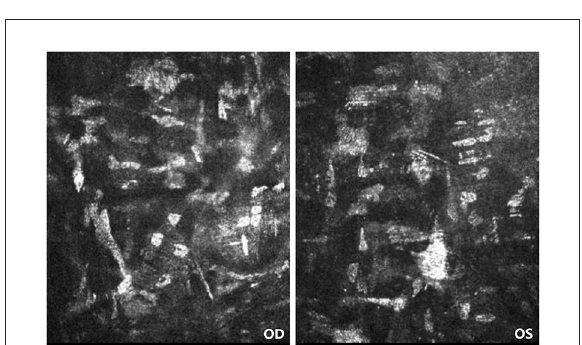
FIGURE2 Confocal microscopy of patient’s both eyes. Confocal microscopy showing the presence of hyper-reflective deposits that appeared as irregular snowflake-like images between the Descemet memberane and the corneal endothelial